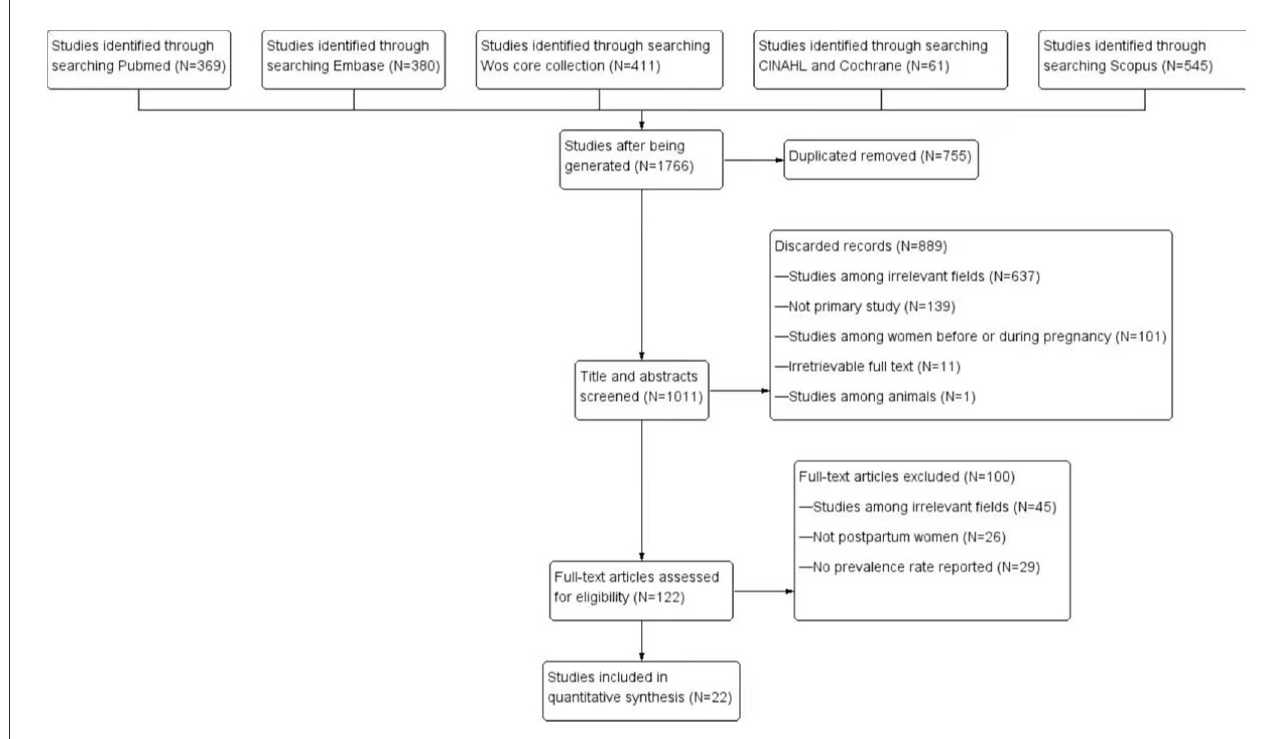
FIGURE1 PRISMA study selection flow